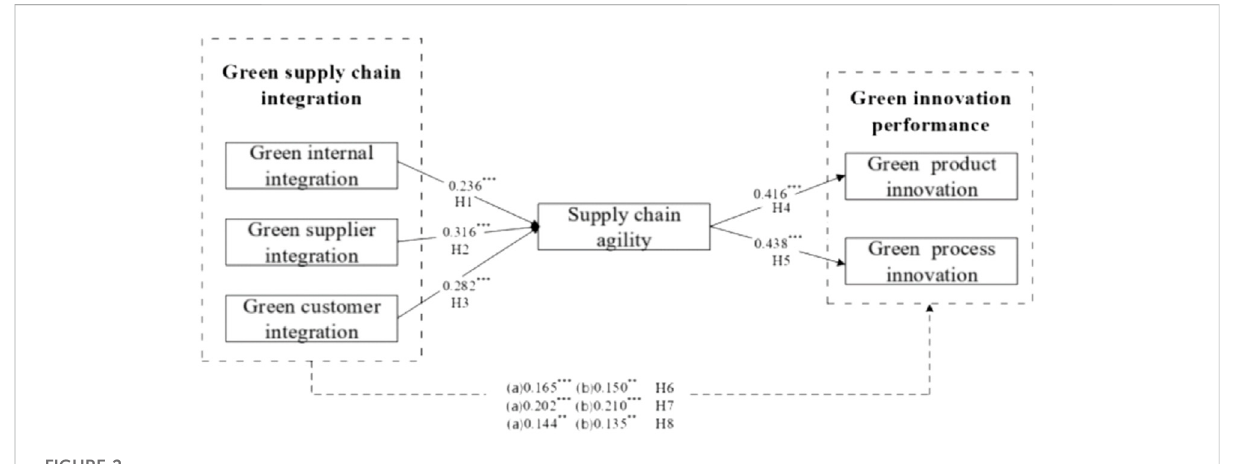
FIGURE 2 Regression model coef fi